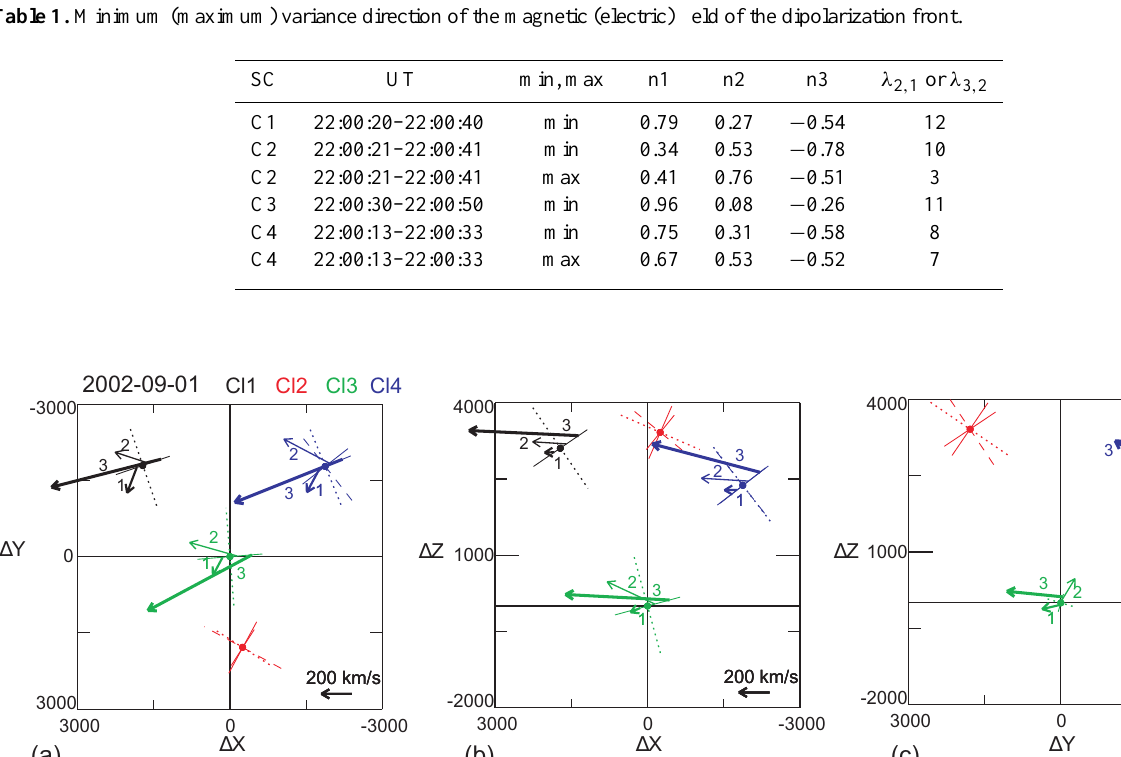
Table 1. Minimum (maximum) variance direction of the magnetic (electric) field of the dipolarization front.